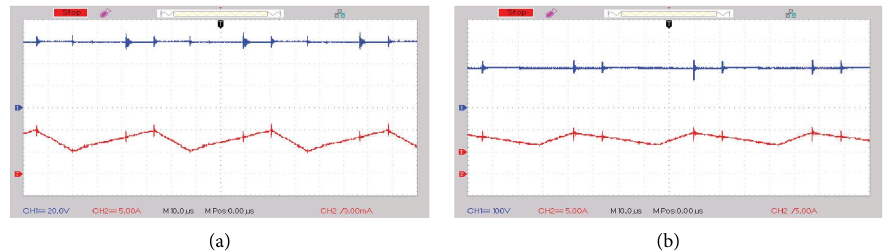
Figure 30: (a) Voltage and current of the frst source. (b) Voltage of the second source and current of the second inductor.